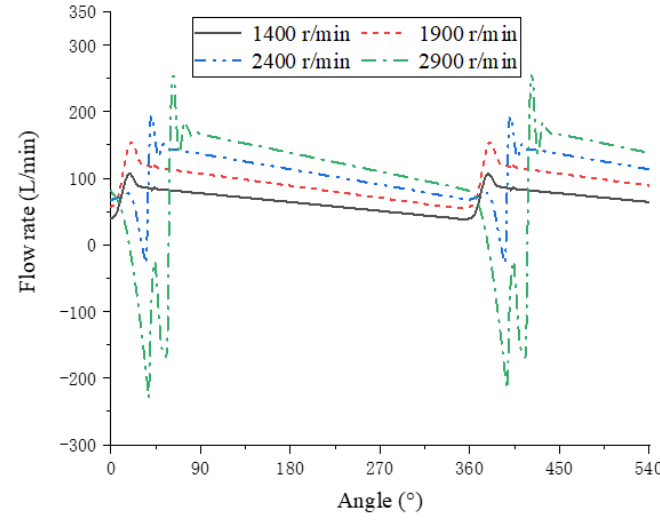
Figure 10. Outlet flow at different rotating speeds.